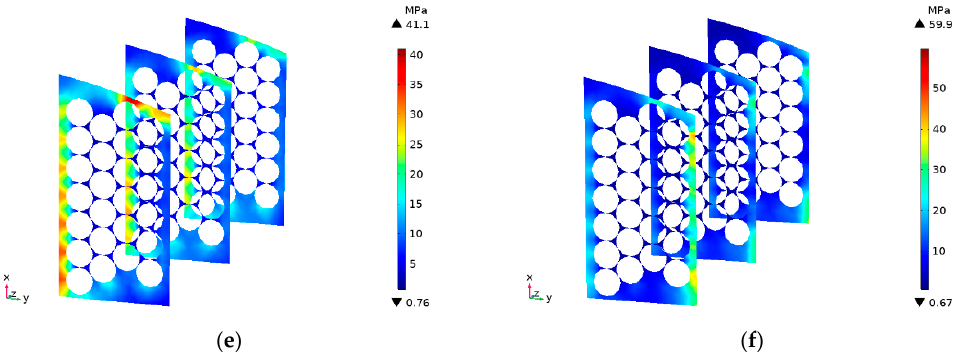
Figure 10. Resulting stress distribution for DCC1 and DCC2. ( a , b ) show the overall stress distribution; ( c , d ) show the stress in the copper coils; ( e , f ) show the stress in three different positions along the axial length of the machine.